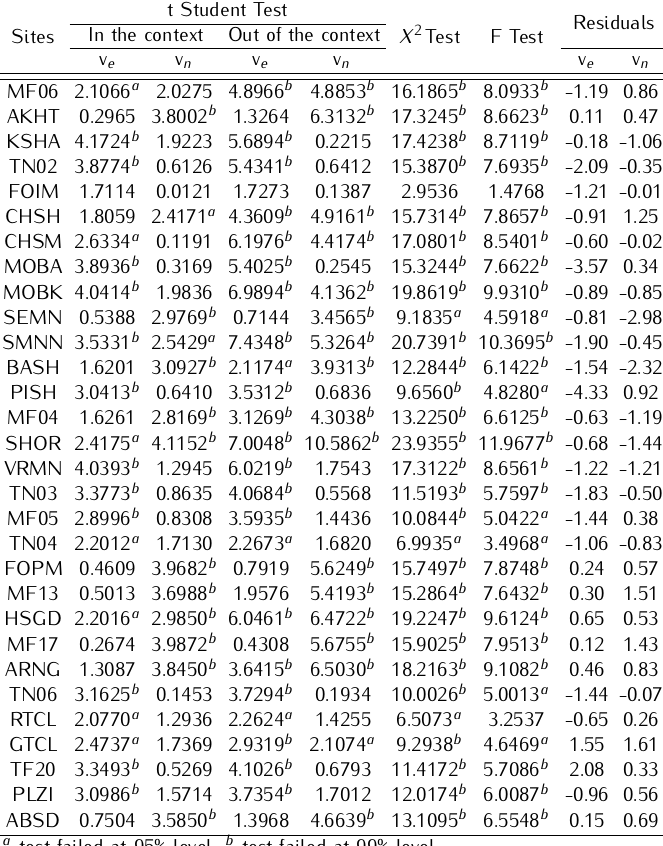
Table 11. Tests results (block B13). The results of the statistical tests for the GPS site data components. The sites passed from all the tests are the accepted data. The tests have been performed in two confidence levels (95% and 99%). t Student Test Sites X 2 Test F